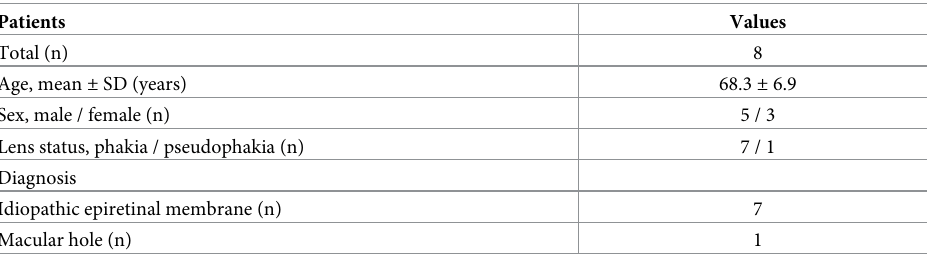
The mean timolol concentrations in the vitreous and aqueous humors were 65.6 ± 56.0 nM and 3,160 ± 1,570 nM, respectively (Fig 4). No significant correlation was found between timo- lol concentrations in the aqueous and vitreous humors (Fig 3B.; P = 0.92, R 2 = 0.002). Signifi- cant positive correlations between brimonidine and timolol concentrations were detected in Table 1. Patient